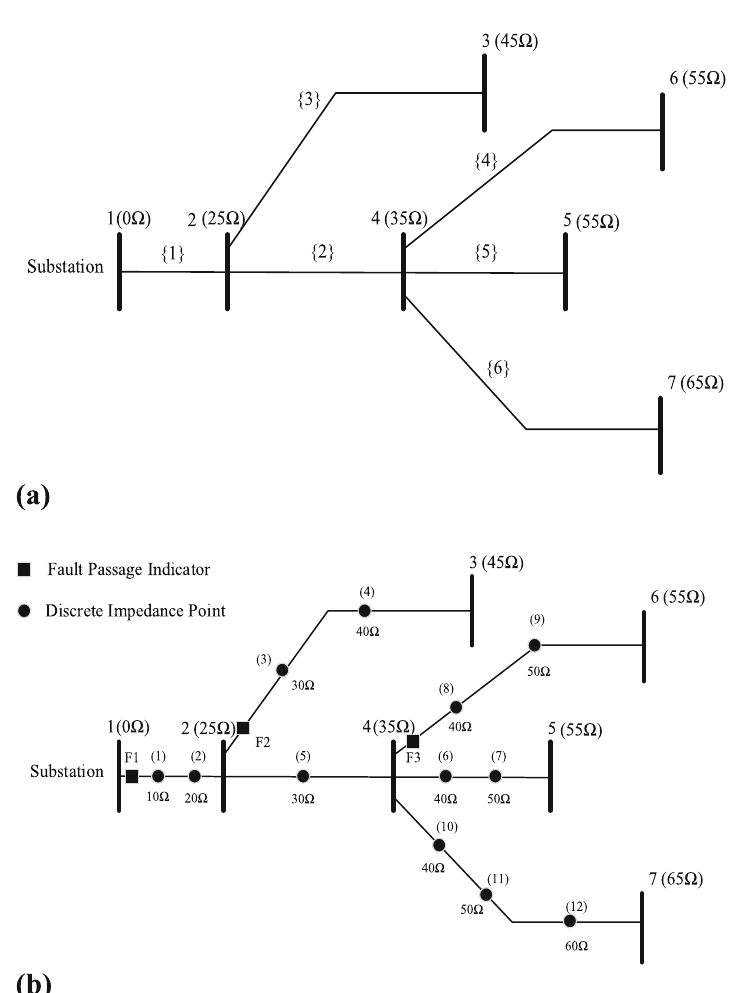
Fig. 2 a Seven bus radial feeder. b FPIs placed in seven bus feeder with an impedance step size of 10